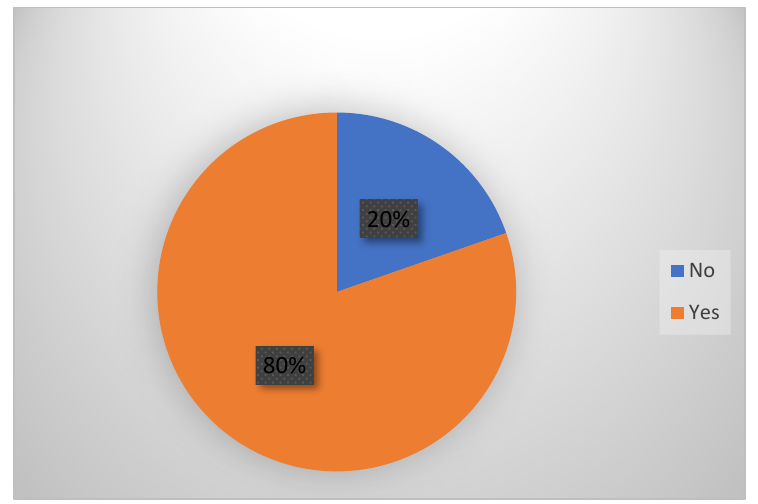
Figure 5. Dichotomous choice results for the willingness to pay for alternative energies (WTPEA).